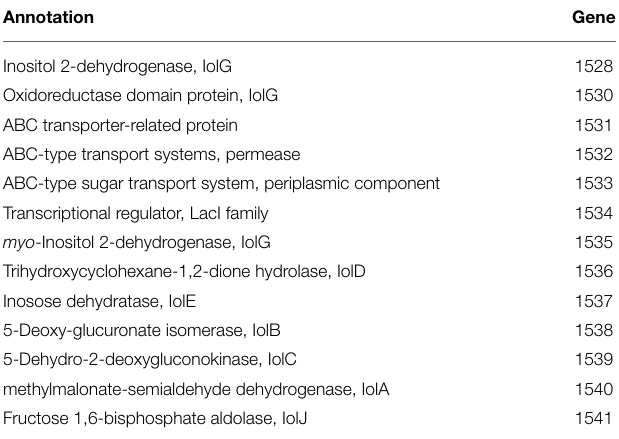
Urea, urease and urea utilization cluster, Inos, inositol-phosphate utilization cluster; α Man, α -mannoside utilization cluster; GLcn gluconate utilization cluster; Mtl, mannitol utilization cluster. The gene sequence values for the corresponding genomes regions are (start-end): MC61, 2635441-2855821; MC52, 1775380-1995757; 56T2, 1737107-1912324; 56T3, 1646809-1858633; YS93, 2080803-2255158; 1MC16, contig ABVH01000004 28446-229812.